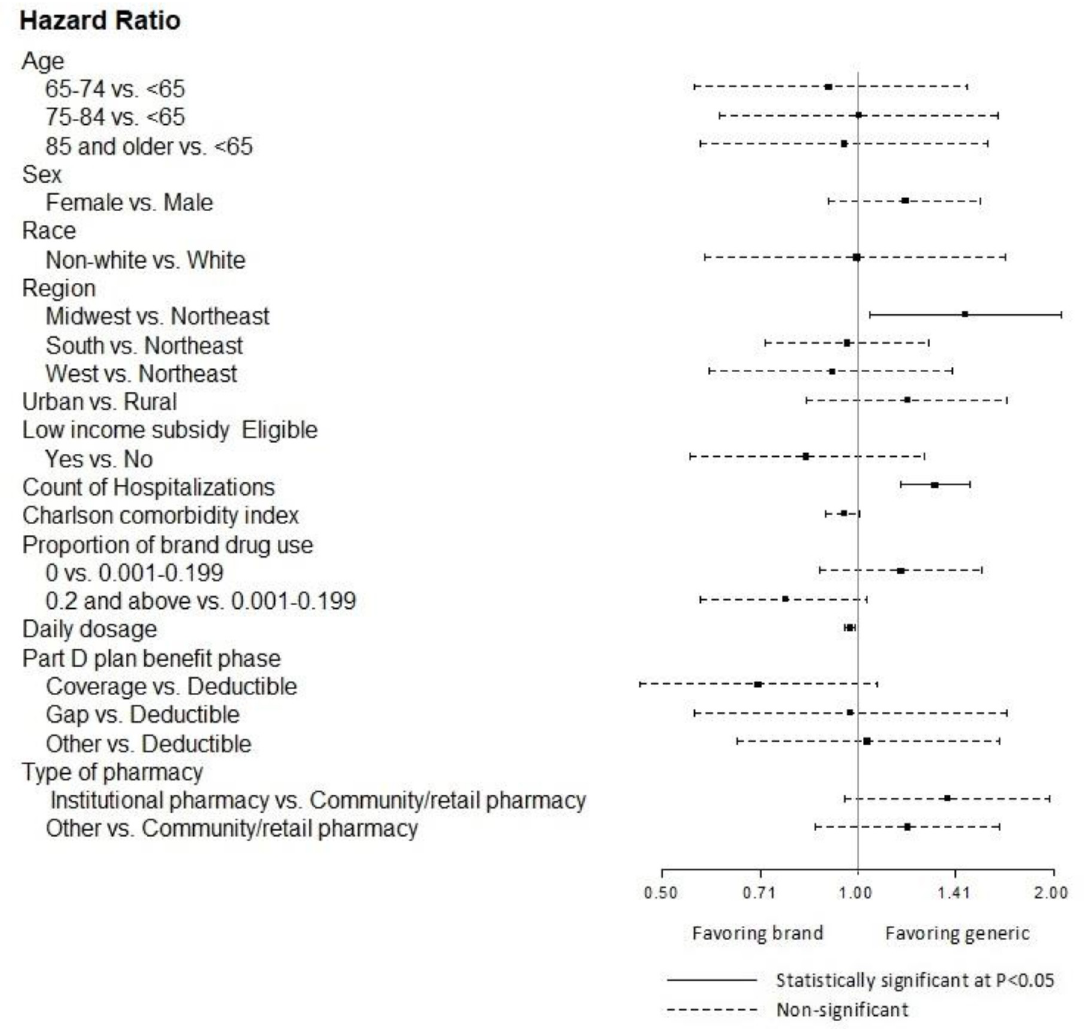
Fig 4. Results from cause-specific proportional hazards model of time to generic substitution within 12 months among brand escitalopram initiators (adjusted hazard ratios and 95% CI).